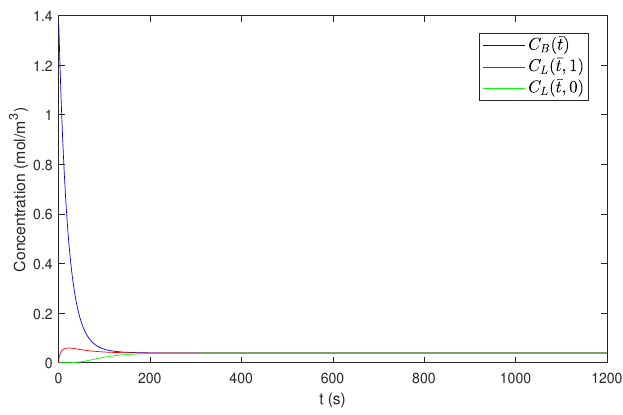
Figure 7. Dynamics of the concentrations obtained from the simplified model ( α = 41 . 4, β = 0 . 4) for the data reported in [16].